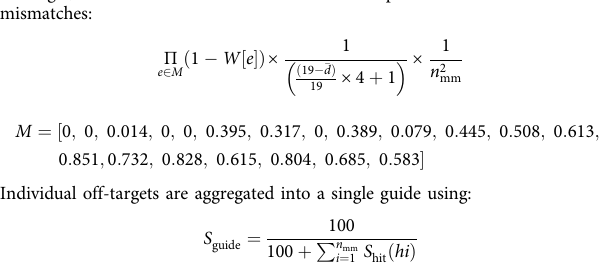
CRISPR screens . The guide libraries targeting the TNFAIP3 locus for CRISPRi and CRISPRa are available in Supplementary Data 4 and 7. To design the guide library, all possible 20 bp sgRNAs with the Cas9 protospacer adjacent motif NGG within the region surrounding TNFAIP3 (chr6:13784700 – 138453100, hg19) were considered. On-target scores for each guide were determined using the Rule Set 2 method described in ref. 66 . To determine the number of off-target locations, bowtie (0.12.7) 67 was used to map guides to the human reference (hg19) with a maximum 10,000 matches, with up to three mismatches (parameters: -n 3 -l 15 -e 10000 -y --all -S). Using this set of potential mapping locations in the genome, off- target score was calculated using the method of Hsu et al. 68 . Brie fl y, single off targets were calculated as e moves over positional mismatches between guide and off-target, where the m is as below and d is mean pairwise distance